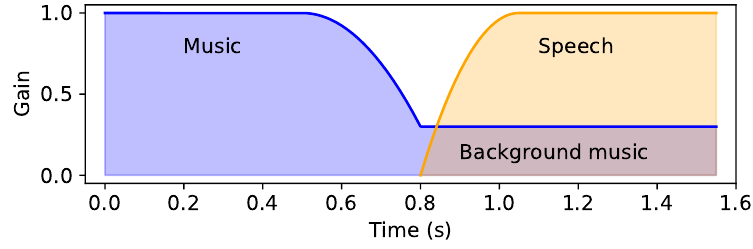
Figure 2. An illustration of audio ducking while synthesising multi-label